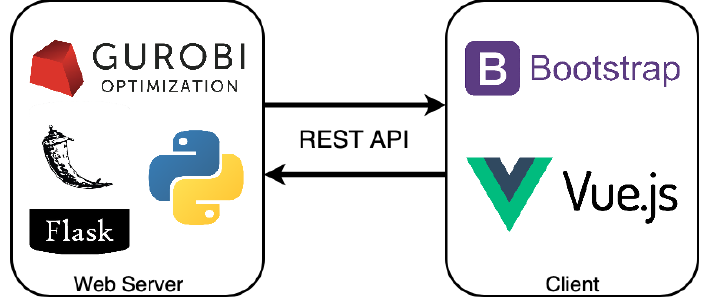
Figure 13. Web service